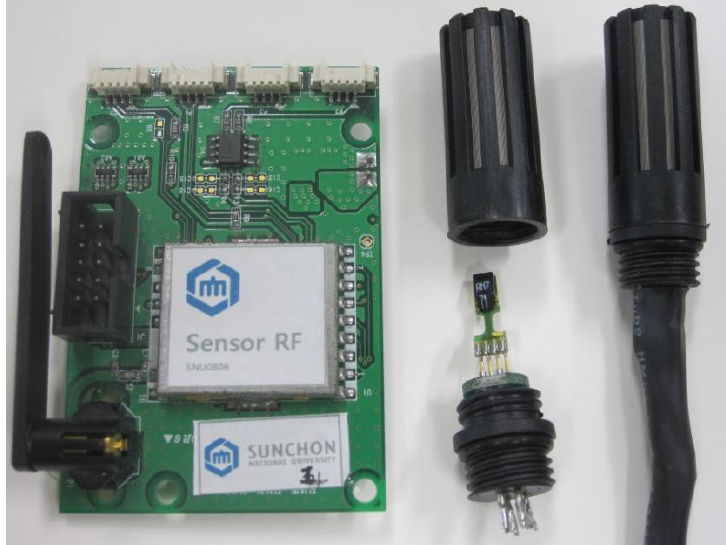
Figure 10. WSN Environmental